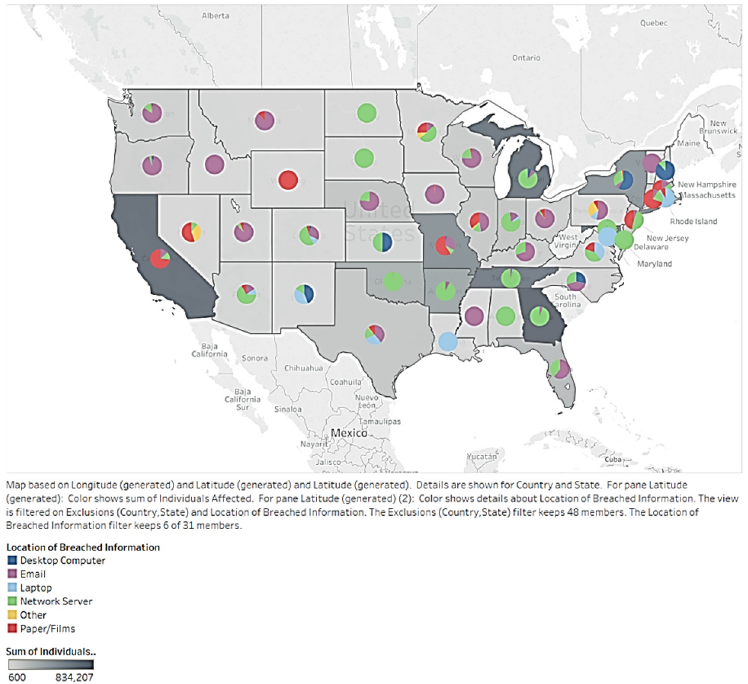
Figure 22. Geographical distribution of affected individuals by state and location of breached infor- mation.